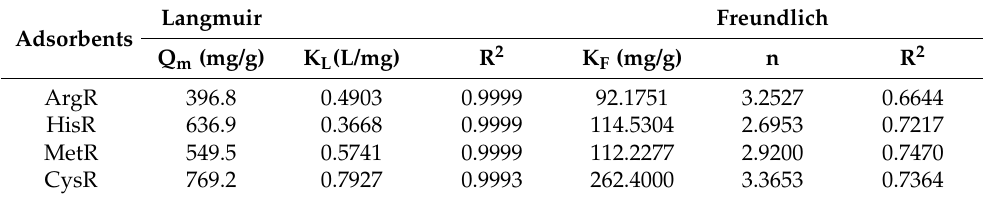
Table 2. Adsorption isotherm parameters for Au(III) absorbed by amino acid resins.